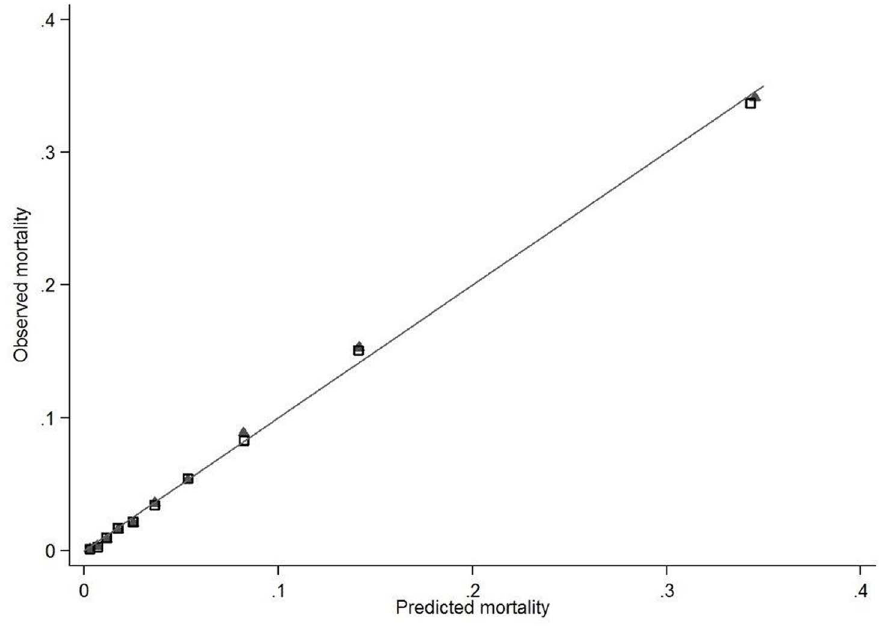
Figure 2. Model Calibration by Deciles of Predicted Risk in the Development and Validation Cohorts.